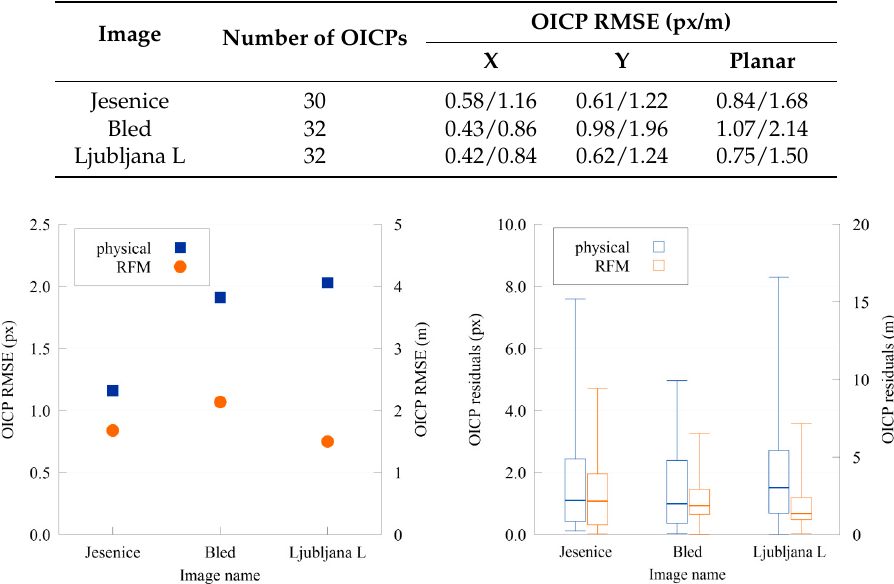
Table 8. Accuracy of the WorldView-2 orthoimages generated with RFM compared to the reference aerial orthophoto.